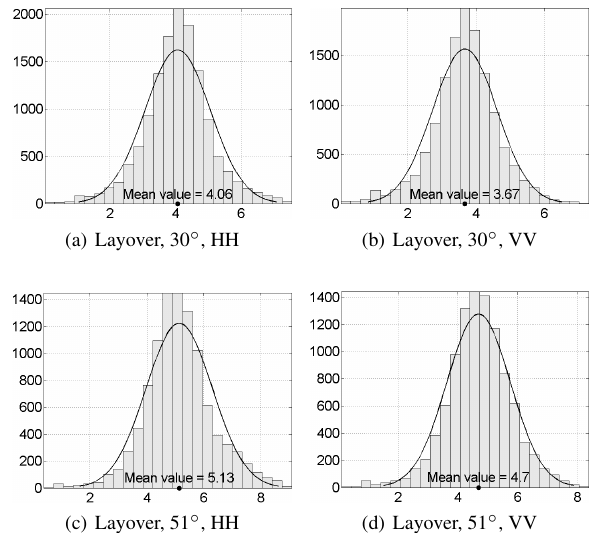
Figure 2. Hansaviertel, intensity distribution of layover pixels for different polarizations and incidence